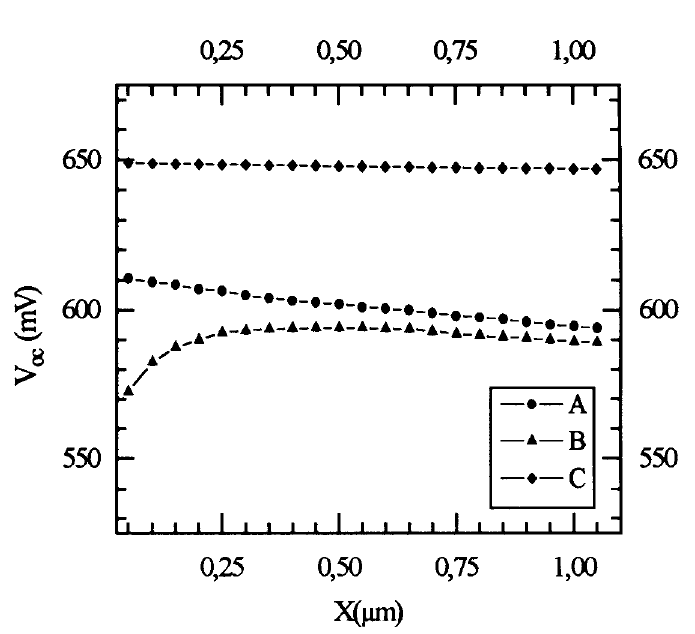
FIGURE 6 Variation of the open circuit voltage V oc according to the thickness X of the emitter. For curves (A), (B) and (C), we have: Curve (A): N D ¼ 10 20 cm (cid:2) 3 ; N A ¼ 10 19 cm (cid:2) 3 ; H ¼ 295 m m ; S b ¼ 10 5 cm (cid:3) s (cid:2) 1 S f ¼ 100cm (cid:3) s (cid:2) 1 Curve (B): N D ¼ 10 20 cm (cid:2) 3 ; N A ¼ 10 16 : 5 cm (cid:2) 3 ; H ¼ 295 m m ; S b ¼ 10 5 cm (cid:3) s (cid:2) 1 S f ¼ 10 6 cm (cid:3) s (cid:2) 1 Curve (C): N D ¼ 10 19 cm (cid:2) 3 ; N A ¼ 10 17 : 5 cm (cid:2) 3 ; H ¼ 295 m m ; S b ¼ 10 5 cm (cid:3) s (cid:2) 1 S f ¼ 10 2 cm (cid:3) s (cid:2) 1